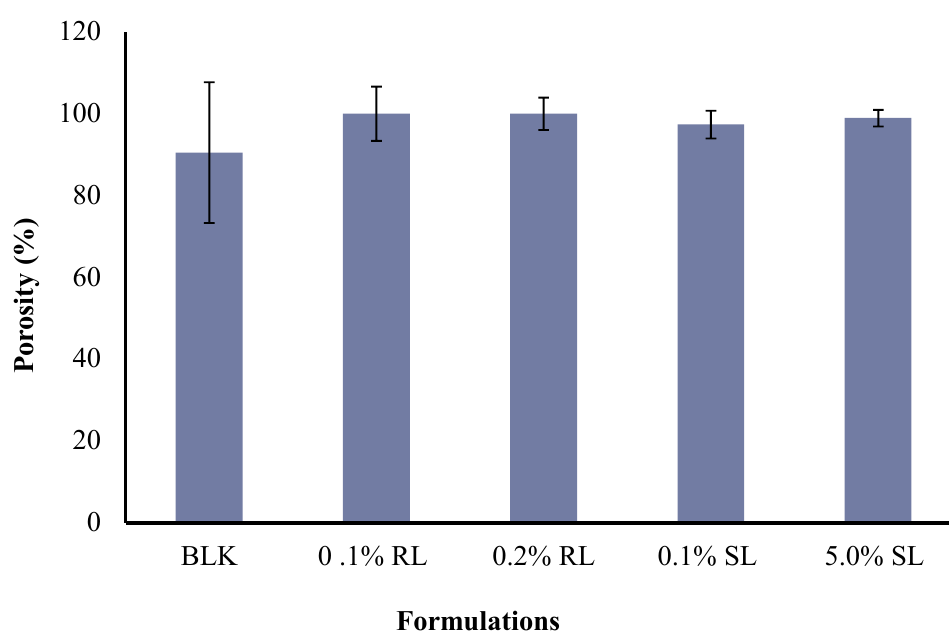
Figure 6. Comparison of the porosities of optimized BLK and BSs loaded composite wafers.